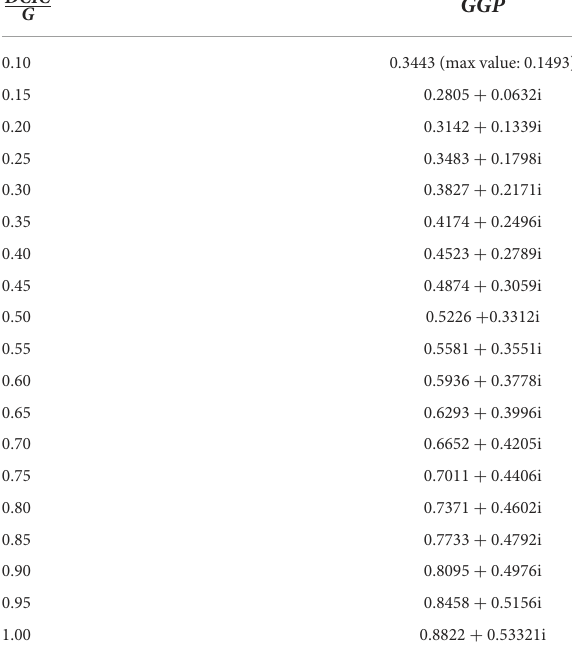
TABLE 1B Critical Value points for the IFFG